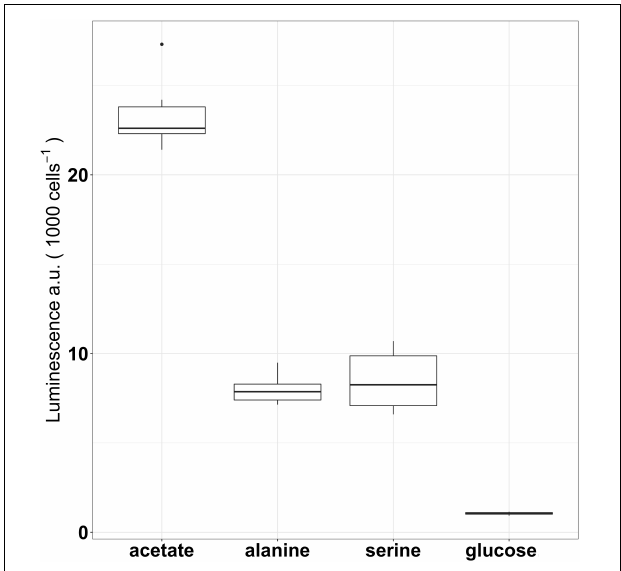
FIGURE 2 | Expression of icl as luminescence per 1000 cells of icl-luc grown under different carbon sources (100 µ M[C]) using six replicates per condition. Outliers are marked as dots and a.u denotes arbitrary units for